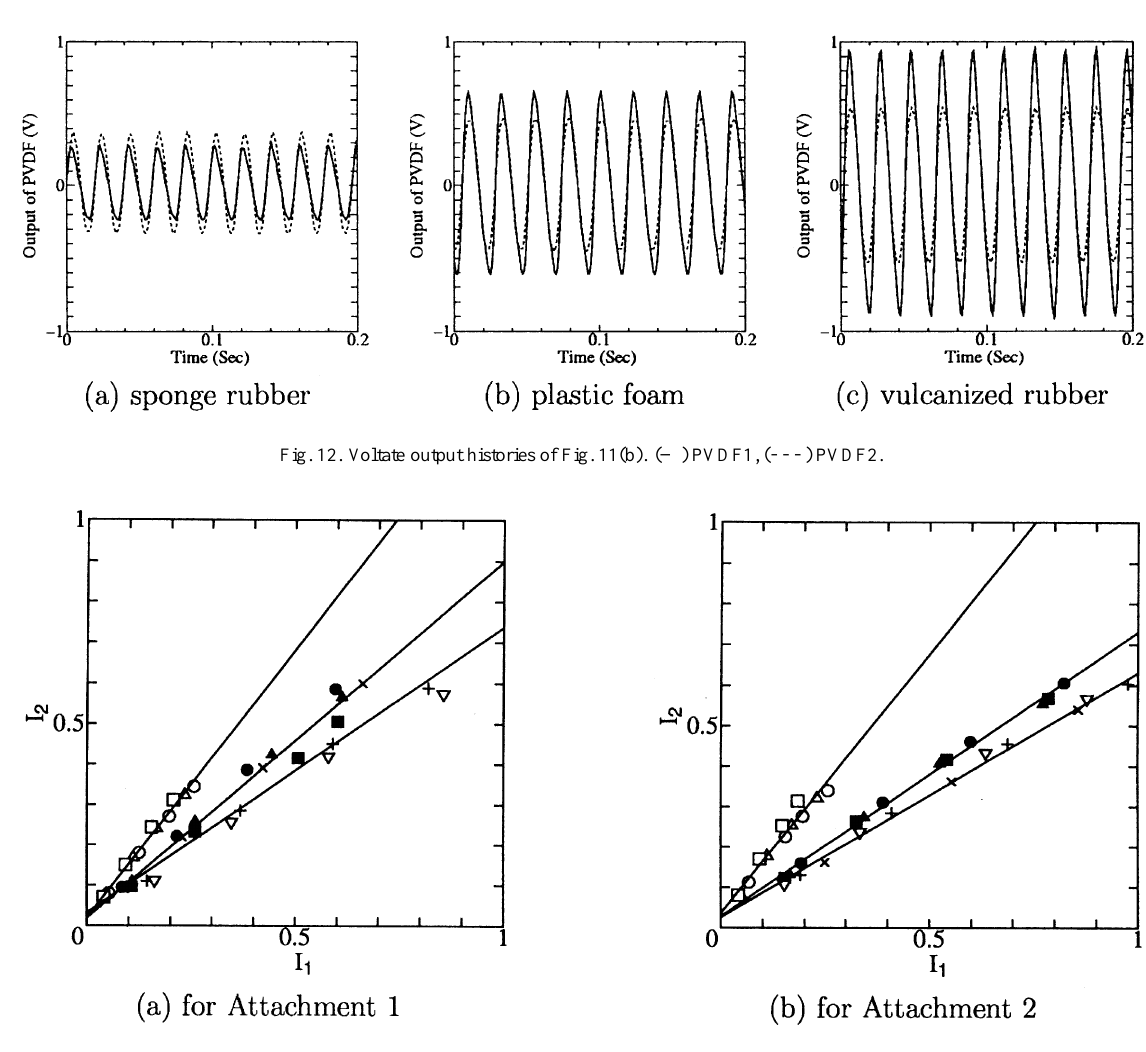
Fig. 13. Output of PVDF1 ( I 1 ) versus that of PVDF2 ( I 2 ) as sensor against sponge rubber ( rubber ( × , + , (cid:7) ) with inclinations of α = (0 , 5 , 10) degrees.